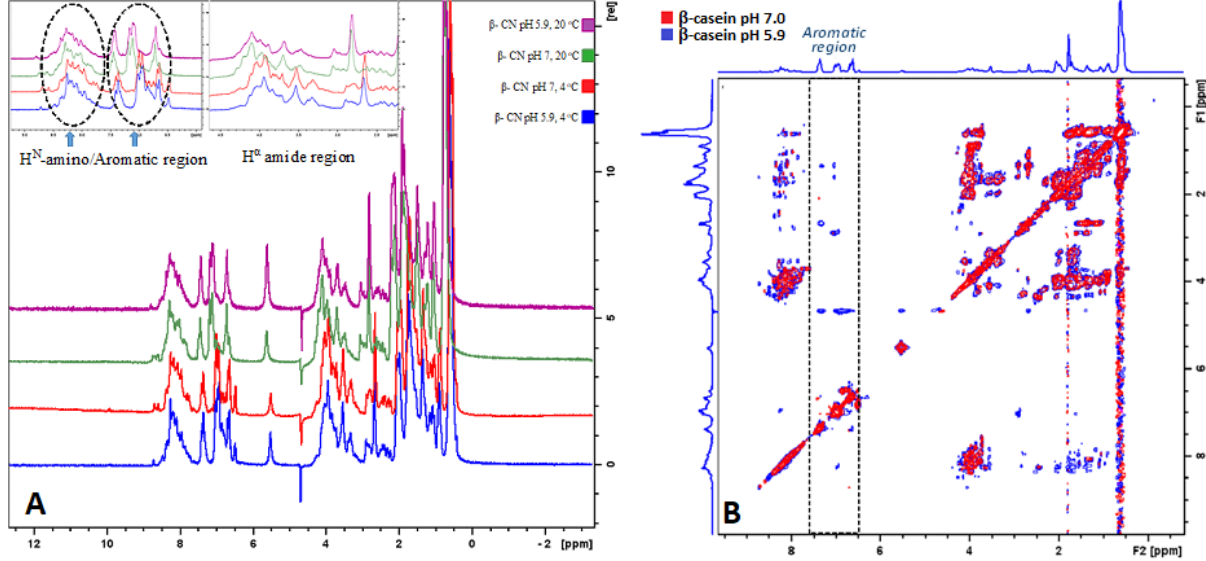
Figure 2. ( A ) Overlayed 1 H NMR spectra of β -casein at pH 5.9 and temperature of 20 ◦ C (purple), β -casein at pH 5.9 and temperature of 4 ◦ C (blue), β -casein at pH 7.0 and temperature of 20 ◦ C (green) and β -casein at pH 7.0 and temperature of 4 ◦ C (red). ( B ) Overlayed TOCSY NMR spectra of β -casein at pH 7.0 (red) and β -casein at pH 5.9 (blue).